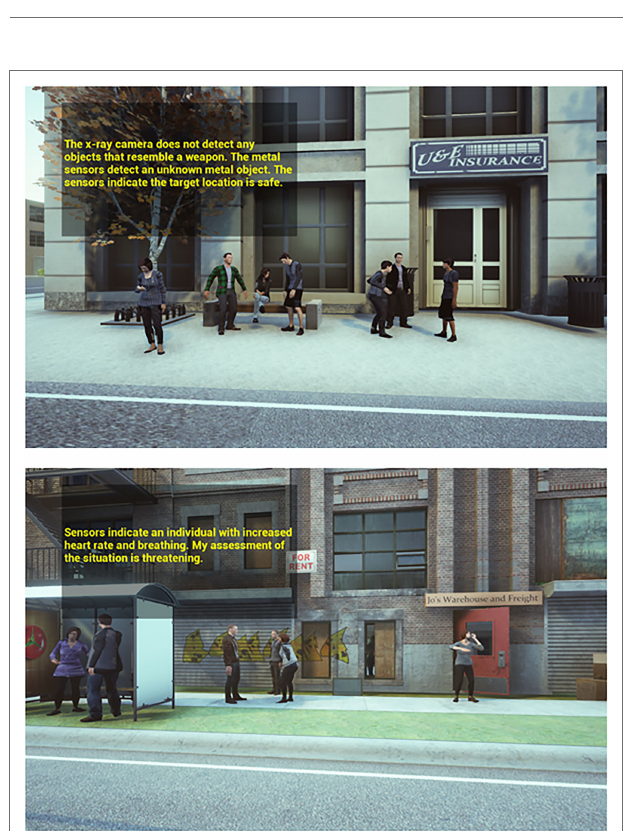
FIGURE 1 | Screenshots from two scenarios. Upper screenshot has low danger-cue level, and the robot makes a physics-based evaluation of safety. Lower screenshot has high danger-cue level, and the robot makes a psychological evaluation of